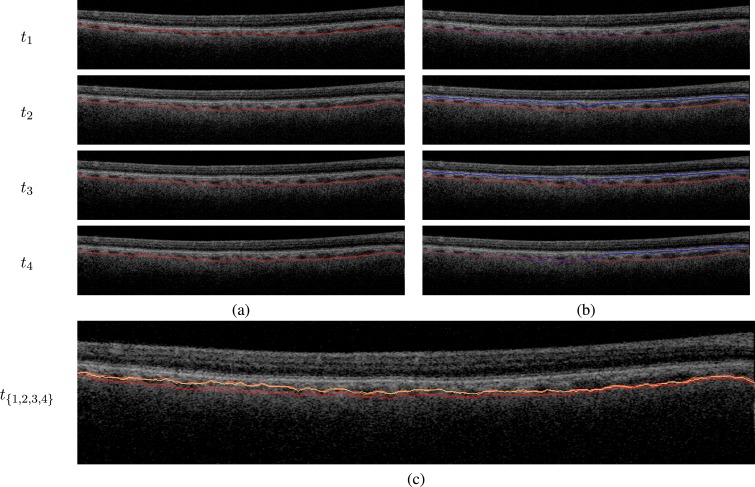
Choroid segmentation in a synthetically deforming time sequence. Four consecutive time points are shown in subsequent rows. (a) Deformed OCT image at that time point. The choroid surface at t4 is overlaid on each image to help highlight the temporal changes. The t1 image can be appreciated to have a thicker choroid than the t2−t4 images, especially on the nasal side. (b) The 3D (blue) and 4D (red) lower choroid surfaces at each time point, overlaid with the deformed OCT image at that time point. The two methods closely agree in the t1 image. At t2 and t3, the 3D segmentation fails throughout most of the B-scan (except in the center) and captures the upper boundary of the choroid rather than the lower boundary. At t4, the 3D segmentation is successful in only the temporal side of the image and locks onto the wrong surface in the nasal side. Four-dimensional segmentation (red) leverages temporal regularization to successfully segment all four time points. (c) The 4D segmentations from each time point are overlaid on the t1 OCT image (different shades of red represent different time points). It can be clearly seen that the t1 segmentation is substantially different than the t2−t4 segmentations, with more pronounced thickening in the temporal side than in the nasal side, in accordance with the data. This illustrates that the temporal regularization is not an obstacle to sensitivity to temporal change actually present in the data.